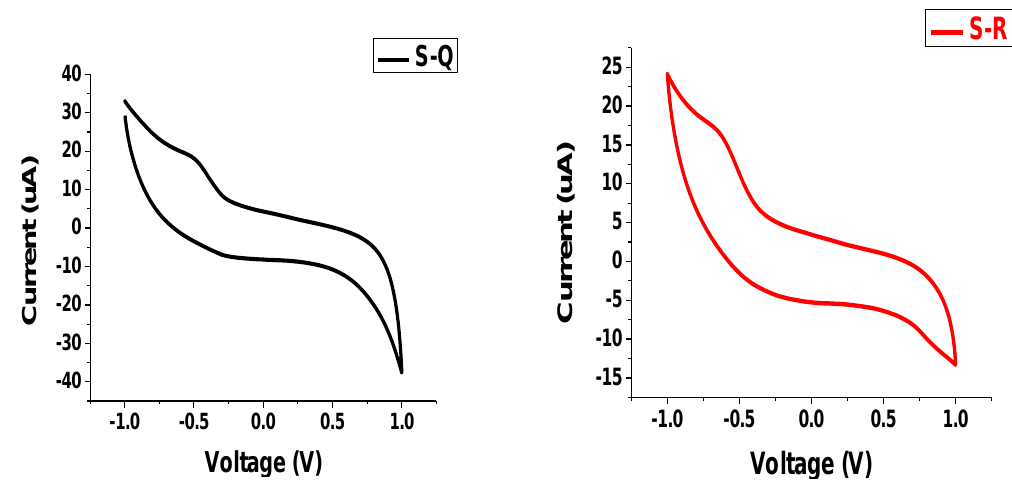
Figure 3. Cyclic voltammograms of S-Q and S-R.